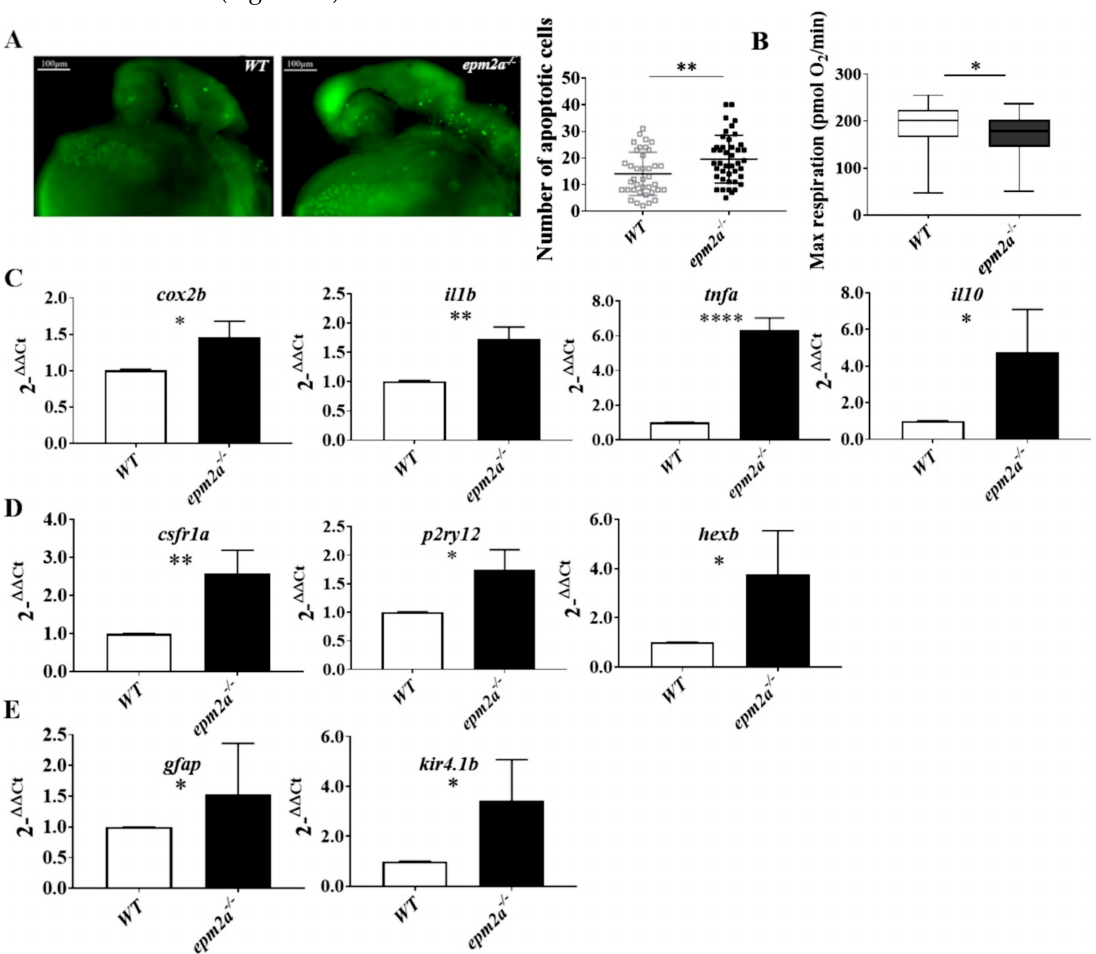
Figure 6. Neuroinflammation, apoptotic death, and mitochondrial dysfunction in epm2a − / − zebrafish larvae. ( A ) Detection of apoptotic cells by acridine orange staining in controls and epm2a − / − mutant embryos at 24 hpf (lateral views) alongside a quantitative analysis of apoptotic cells in WT ( n = 40) and epm2a − / − ( n = 44) fish. ** p ≤ 0.01, calculated by the Mann-Whitney test. ( B ) Mitochondrial respiratory analysis of controls ( n = 47) and epm2a − / − mutant larvae ( n = 48) at 120 hpf. * p ≤ 0.05, calculated by the Mann-Whitney test. ( C ) qRT–PCR analysis of inflammatory and anti-inflammatory cytokines. ( D ) qRT–PCR analysis of microglial genes. ( E ) qRT–PCR analysis of astroglial genes. The mRNA expression levels had been normalized to expression of β -actin . Three independent RNA samples (each obtained from about 30–40 larvae) from controls and epm2a − / − mutant larvae at 120 hpf were analyzed. * p ≤ 0.05, ** p ≤ 0.01, **** p ≤ 0.0001, calculated by Student’s t -test. The values are expressed as mean ±